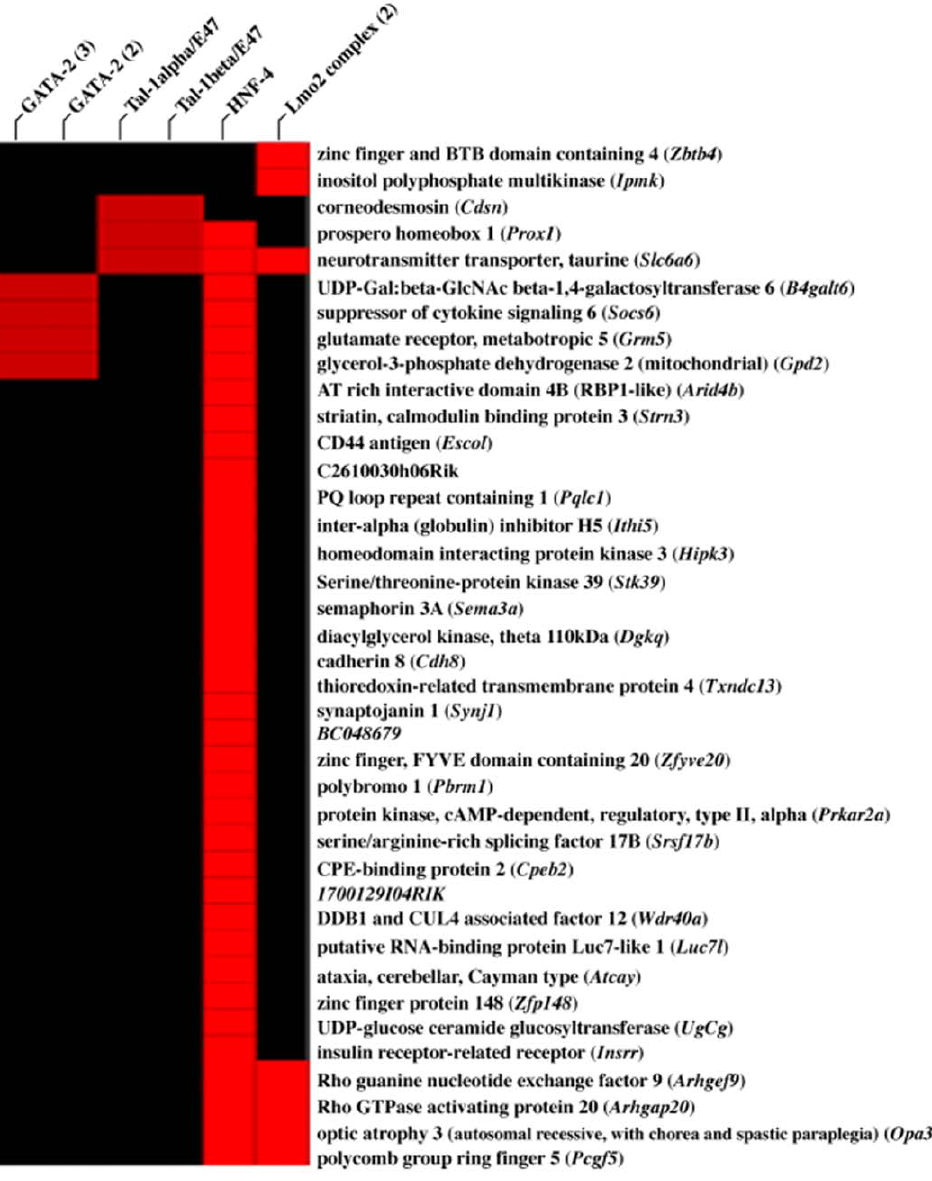
Figure 7. Transcription factor binding-site enrichment hierarchy. Analysis of the promoter regions of the 60-anchored gene sub-set derived from the strain-specific differentially expressed genes between MAM and vehicle-treated animals for transcription regulatory elements. A heat map (interaction matrix) shows the genes (rows) and motifs (columns) that were individually clustered and found in . 5% of all promoters. Note the HNF4 binding site is common to 60% of the 60 anchored